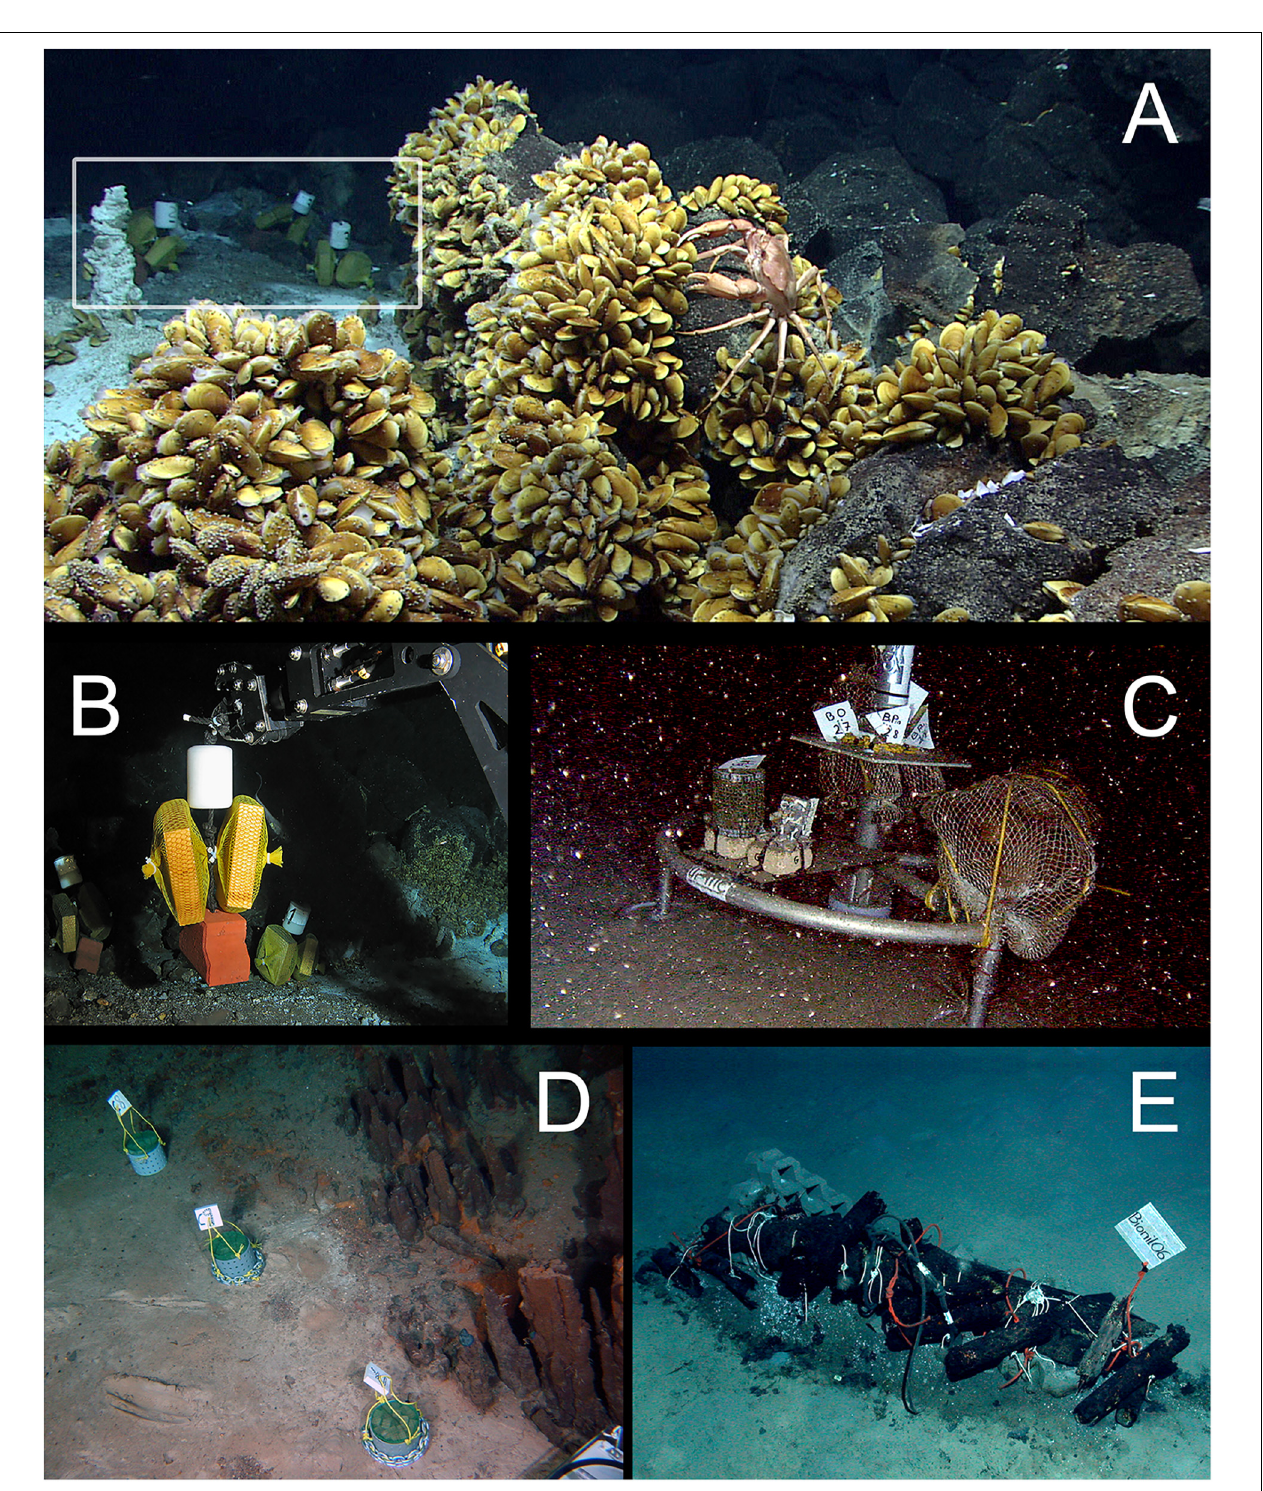
FIGURE 2 | Examples of in situ wood deployments. (A) Small wood panels (white frame) deposited outside of a diffuse flow area in the Menez Gwen hydrothermal vent field (RV Meteor, cruise M82/3); (B) ROV manipulator arm positioning wood panels in panel (A) at Menez Gwen (RV Poseidon, cruise POS402); (C) Moored lander with net bags containing wood blocks in Lacaze-Duthiers Canyon (LECOB LDC monitoring cruises); (D) Chemecoli colonization devices containing small pine wood cubes (2.5 cmł) next to inactive chimneys in the Rainbow hydrothermal vent field (RV Pourquoi Pas?, cruise Momardream); (E) Chemecoli colonization devices and large wood logs in the deep Nile Fan (RV Pourquoi Pas?, cruise Medeco). Copy rights: (A,B,E) MARUM–Center for Marine Environmental Sciences, University of Bremen; (C) Sorbonne Université; (D) Ifremer.